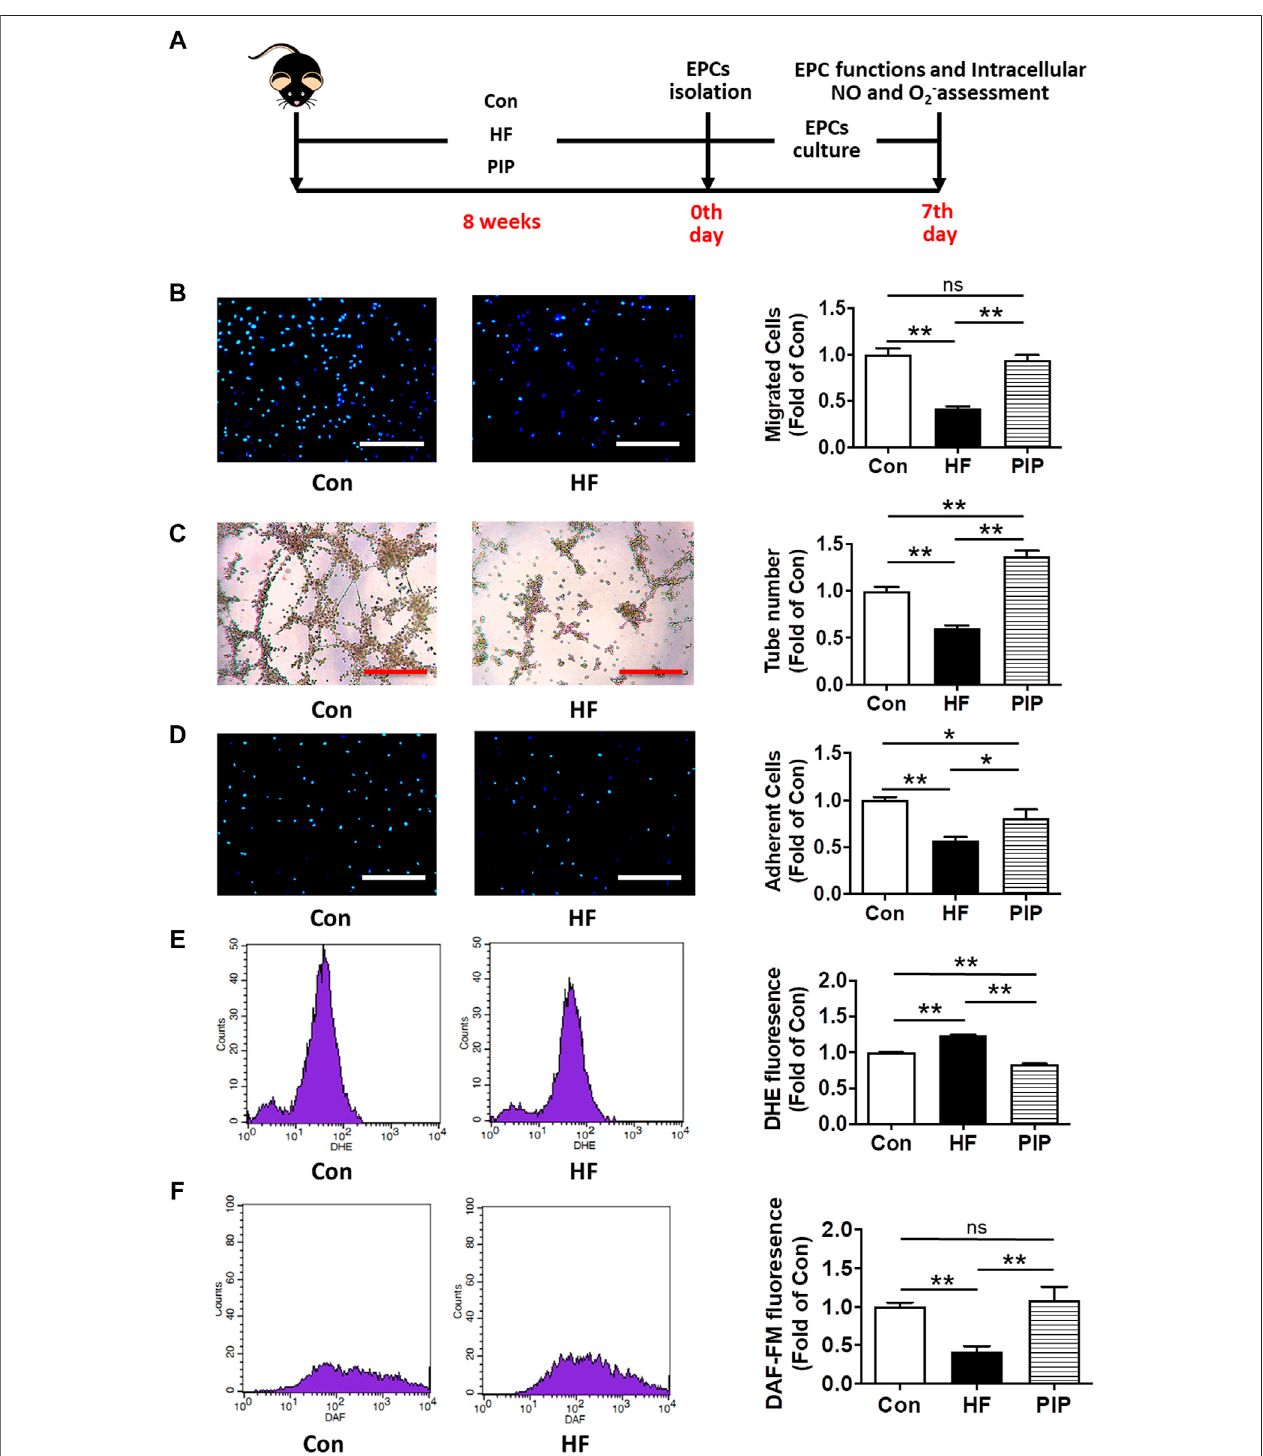
FIGURE 2 | Low-dose Piperlongumine administration rescued EPC dysfunctions in HFD-fed mice. (A) , Experimental protocols: Male C57BL/6 mice (8 weeks) wererandomizedintothreegroupsandfedwithhigh-fatrodentchowwithorwithoutreceivinganintraperitonealinjectionoflow-doespiperlongumine(0.25 mg/kg/d)for 8 weeks.Then,theEPCswereisolated,culturedandexaminedinHFD-fedmice. (B) ,EPCmigrationassay(n (cid:2) 15 – 16). (C) ,EPCtubeformationassay(n (cid:2) 20pergroup). (D) , EPC adhesion assay (n (cid:2) 20 – 26). (E) , Intracellular superoxide level of EPCs assessed by DHE staining fl ow cytometry (n (cid:2) 4 – 5). (F) , Intracellular NO level of EPCs assessed by DAF-FM staining fl ow cytometry (n (cid:2) 4 – 5). Throughout, bars represent means; error bars represent SEM. Values were normalized to Con. * p < 0.05, ** p < 0.01. Con, control mice; HF, HFD-fed mice; PIP, HFD-fed mice treated with piperlongumine. Scale bar: 200 μ m.